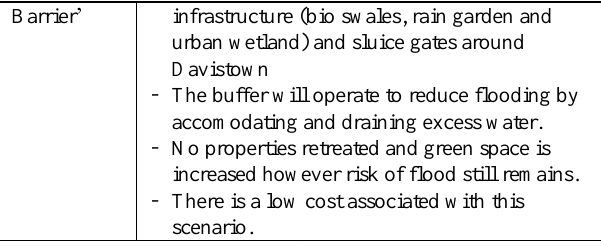
Table 2: Adaptation Scenarios for Saratoga/Davistown The three scenarios involve different levels of social and economic cost. Strategy two with an intermediate social and